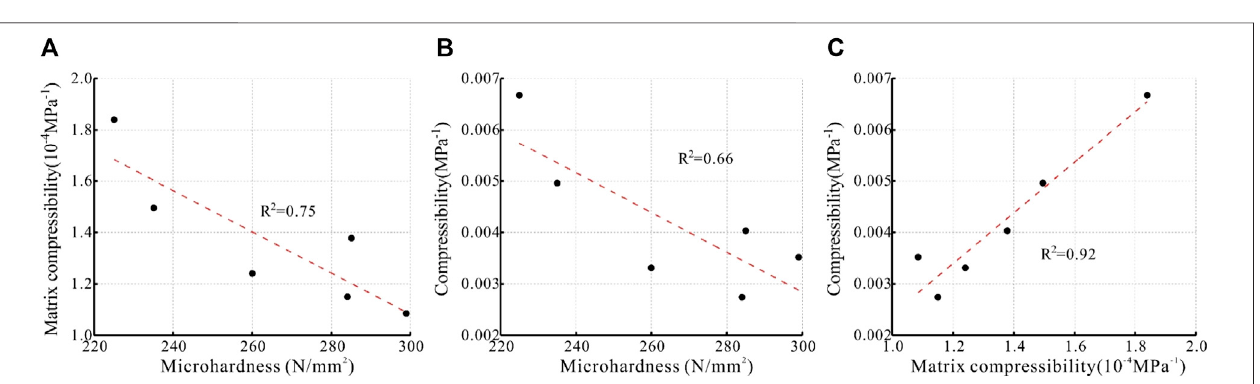
FIGURE 13 | Relationship between microhardness and compressibility of matrix and pore\fracture.